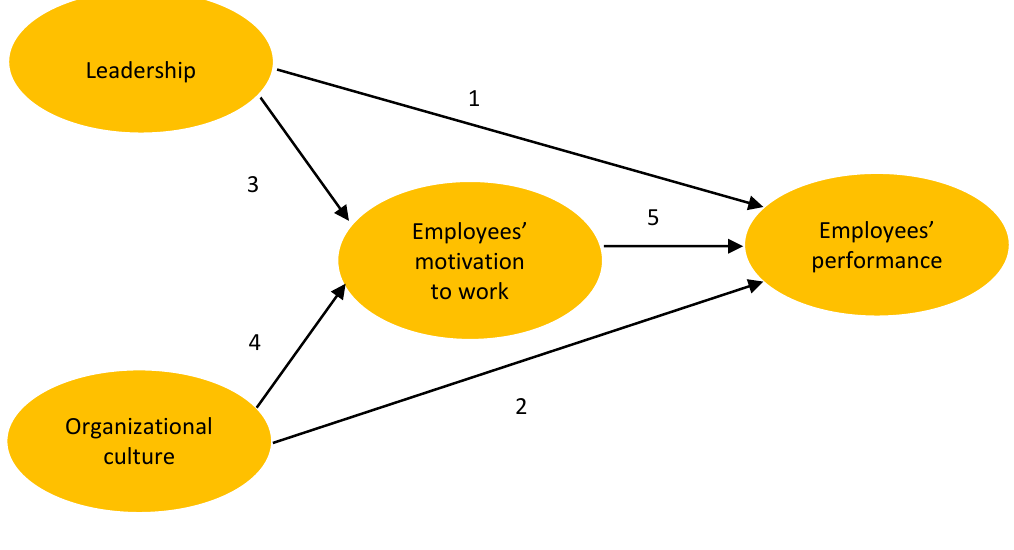
Figure 1. Conceptual